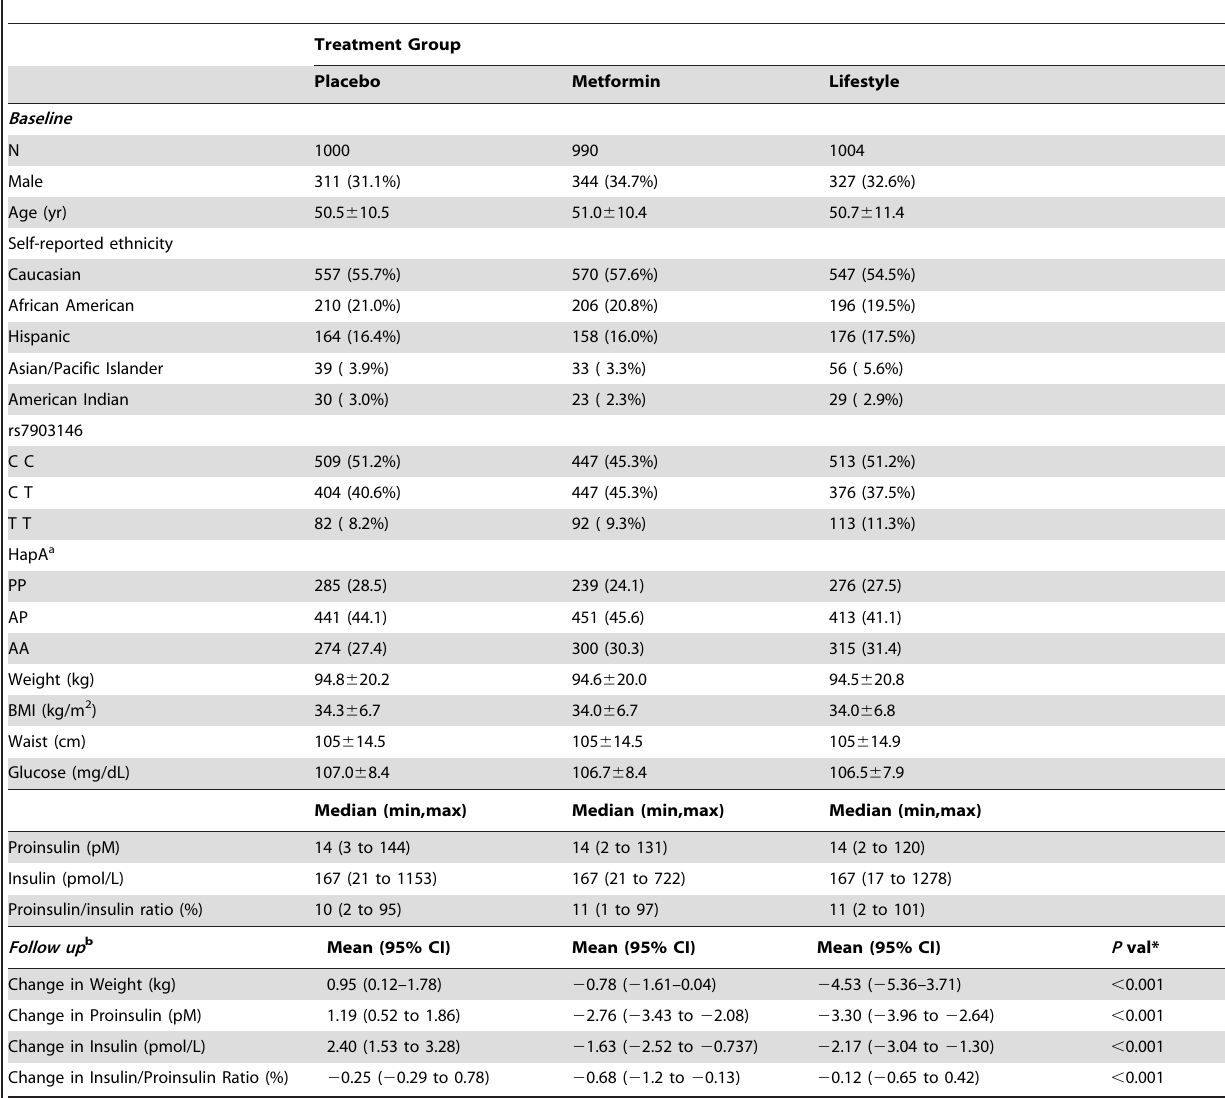
Table 1. Demographic characteristics and baseline and change in weight, proinsulin, insulin and proinsulin:insulin ratio over 2.5 year